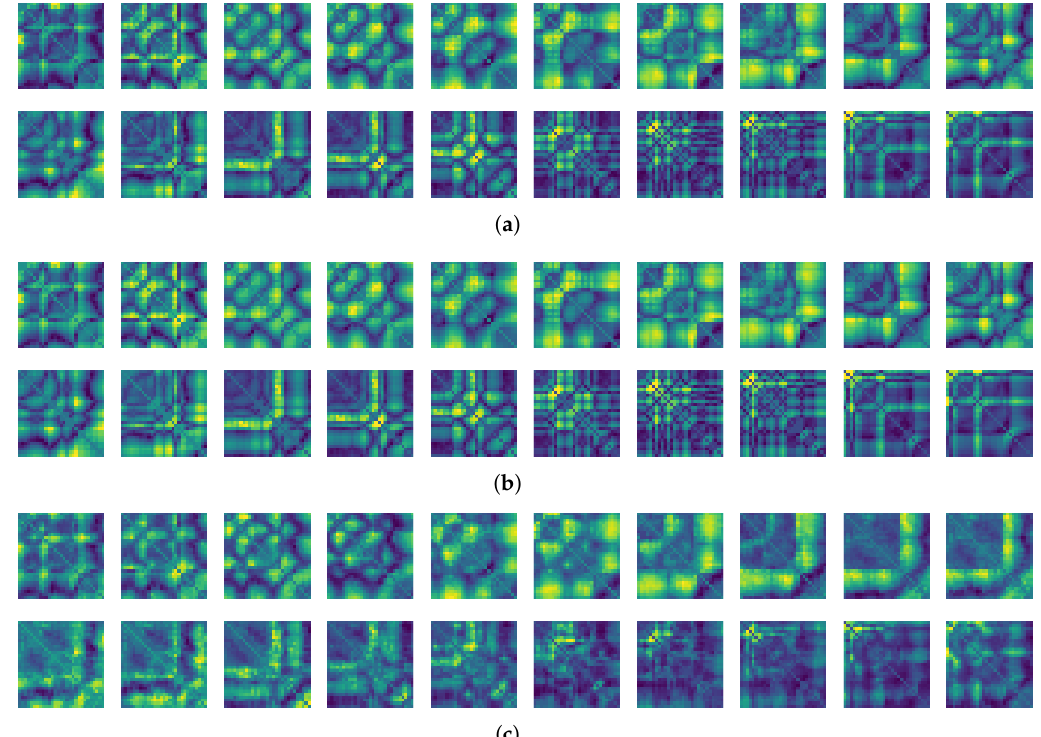
Figure 13. Some samples for running motion: ( a ) predicted results of the FNO model, ( b ) the target recurrence plot data, and ( c ) predicted results of the CNN model.